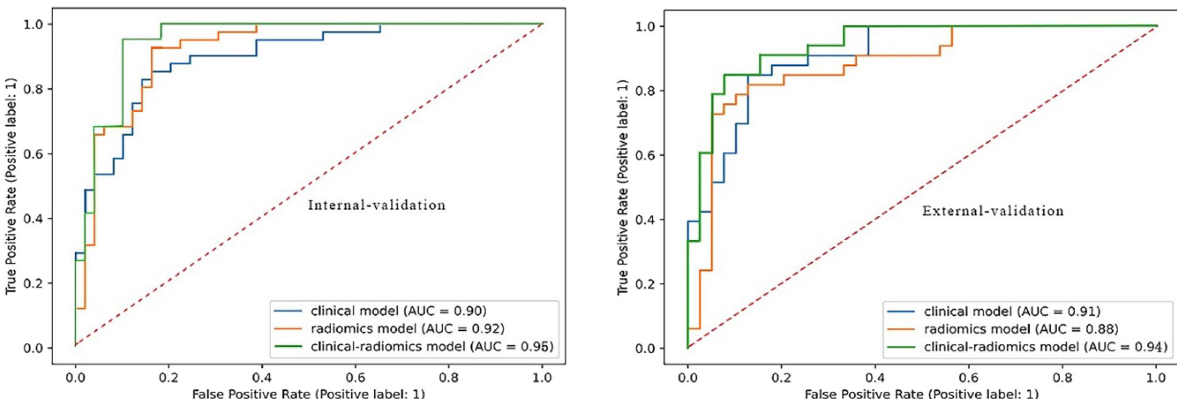
Fig. 5 ROCs of the clinical model, radiomics model, and clinical–radiomics model by XGB (XGB, extreme gradient boosting)